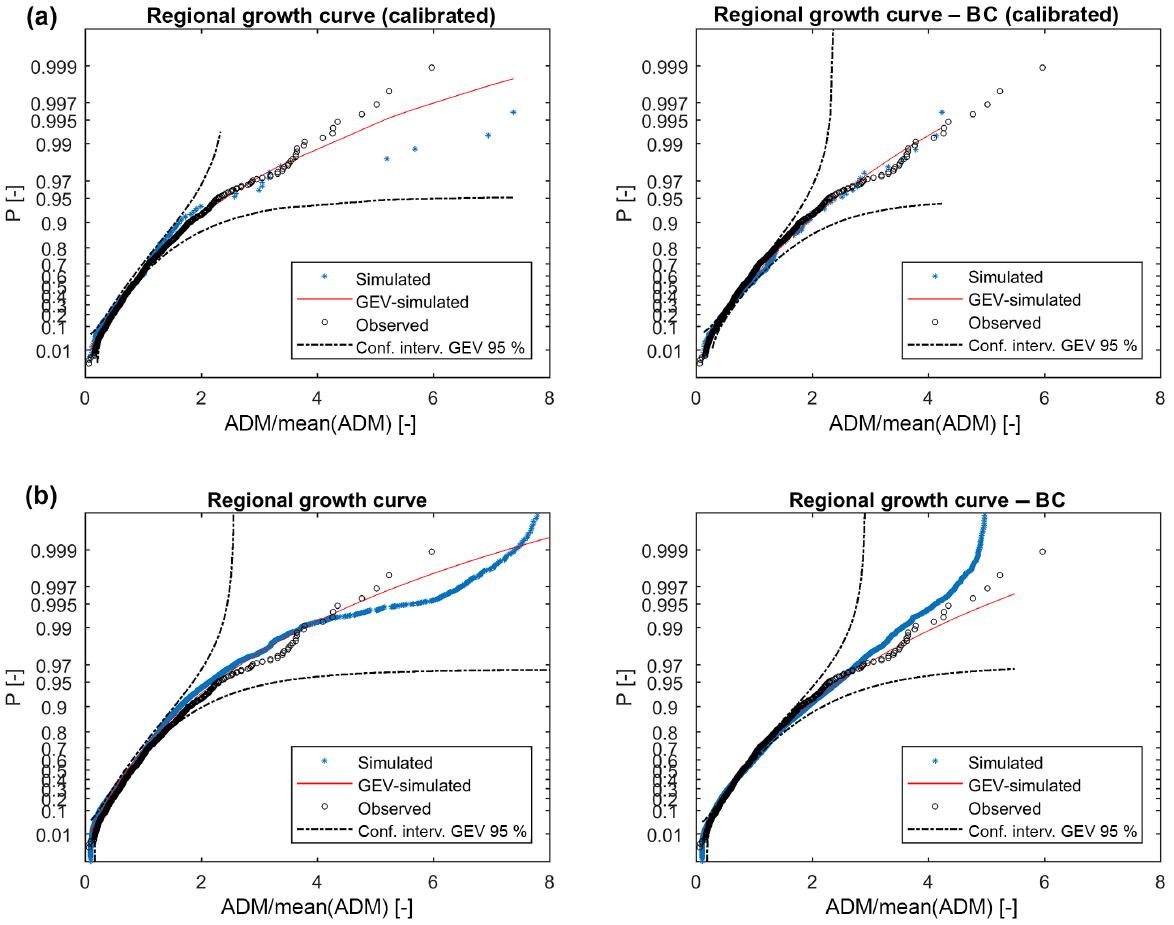
Figure 11. Sample growth curve obtained by the model chain (blue dots) compared with observations (black dots). The red line is the GEV distribution fitted on modeled values while dotted lines are the confidence intervals with a 95% significance. (a) Results without and with rainfall bias correction using the sections where the hydrological model was calibrated. (b) Results without and with rainfall bias correction using all the grid points with drainage area larger than A th = 15km 2